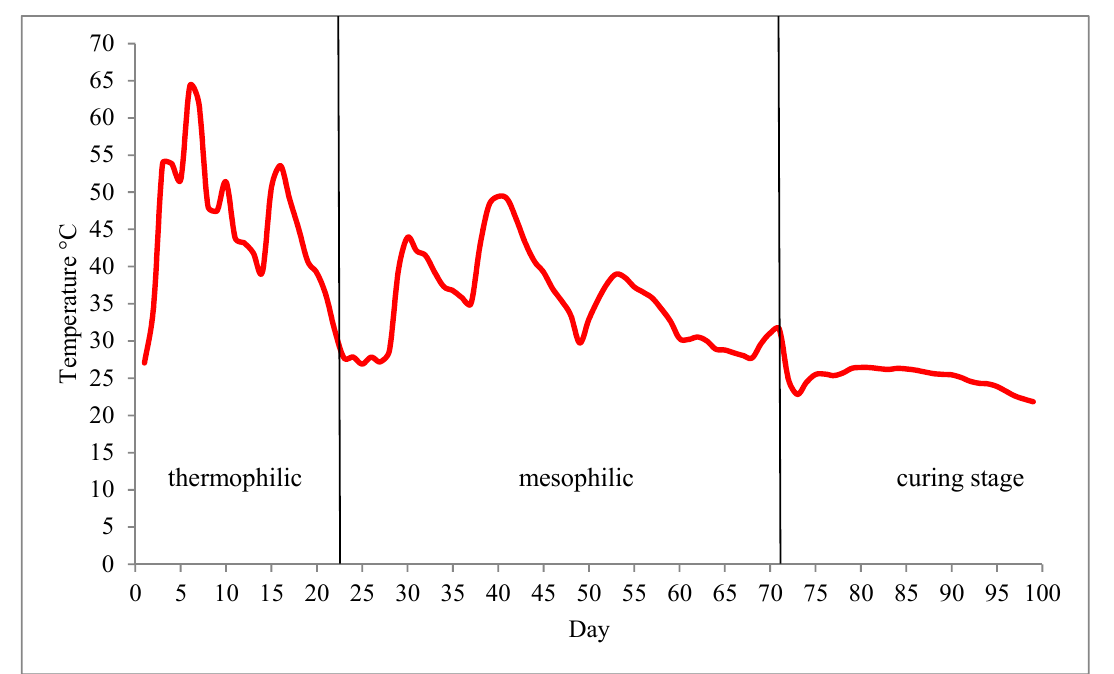
Figure 1. Temperature profile and main phases (thermophilic, mesophilic and curing stages) during the composting pro- cess.